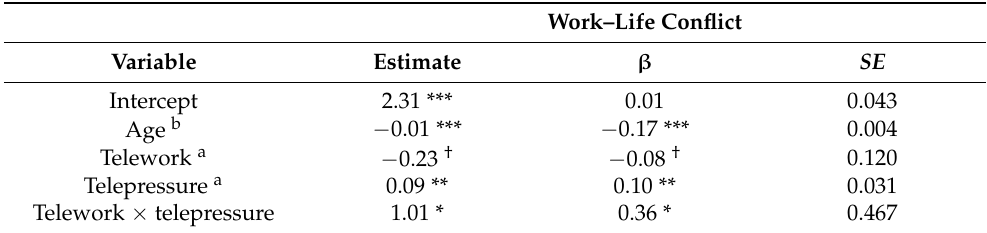
Table 4. Moderation effect of telepressure on work–life conflict.